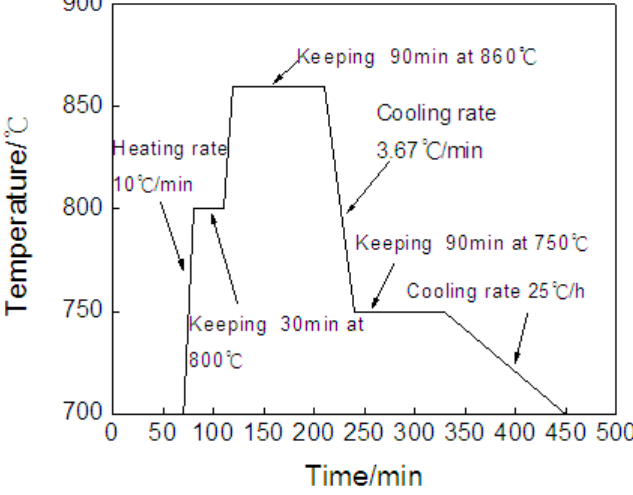
Table 1. Chemical composition of 8Cr13MoV steel (mass %).